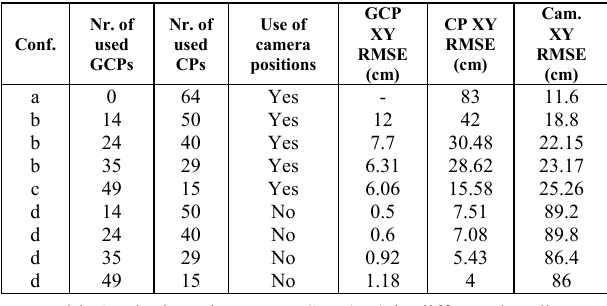
Table 3. Planimetric XY RMSEs (cm) in different bundle- adjustment configurations.